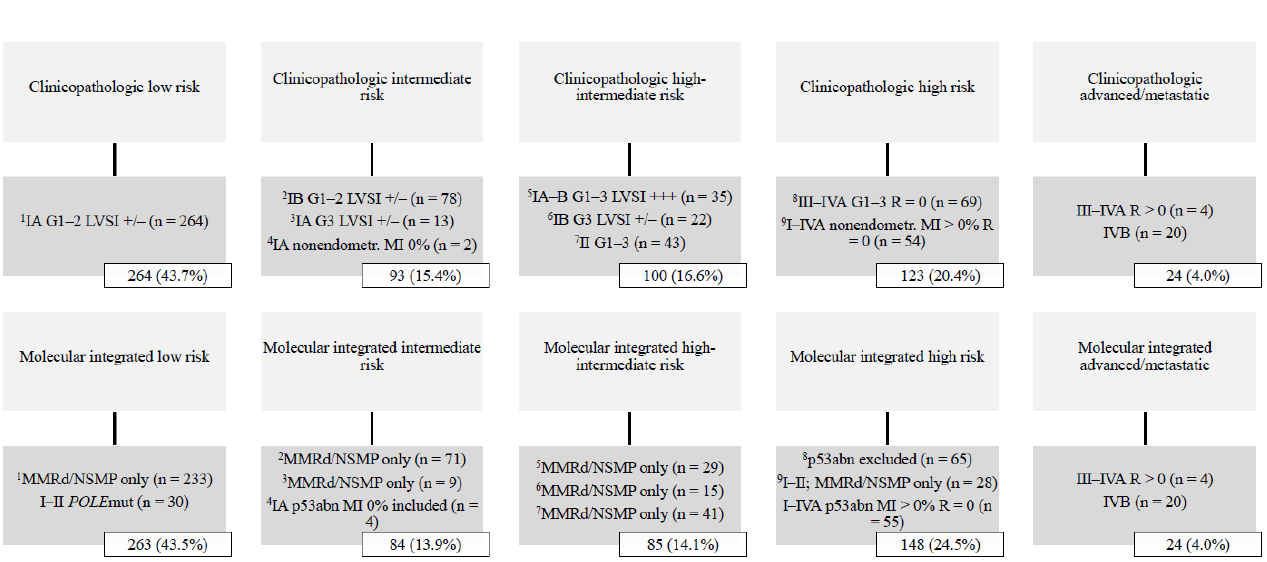
Figure 1. Distribution of ESGO-ESTRO-ESP 2021 risk groups by the ProMisE classifier (n = 604). Abbreviations: G, histologic grade; LVSI +/ − , lymphovascular space invasion focal or negative; LVSI +++, lymphovascular space invasion substantial; MI, myometrial invasion; MMRd, mismatch repair deficient; NSMP, no specific molecular profile; POLE , polymerase- ϵ ; p53abn, p53 abnormal; R, residual tumor.